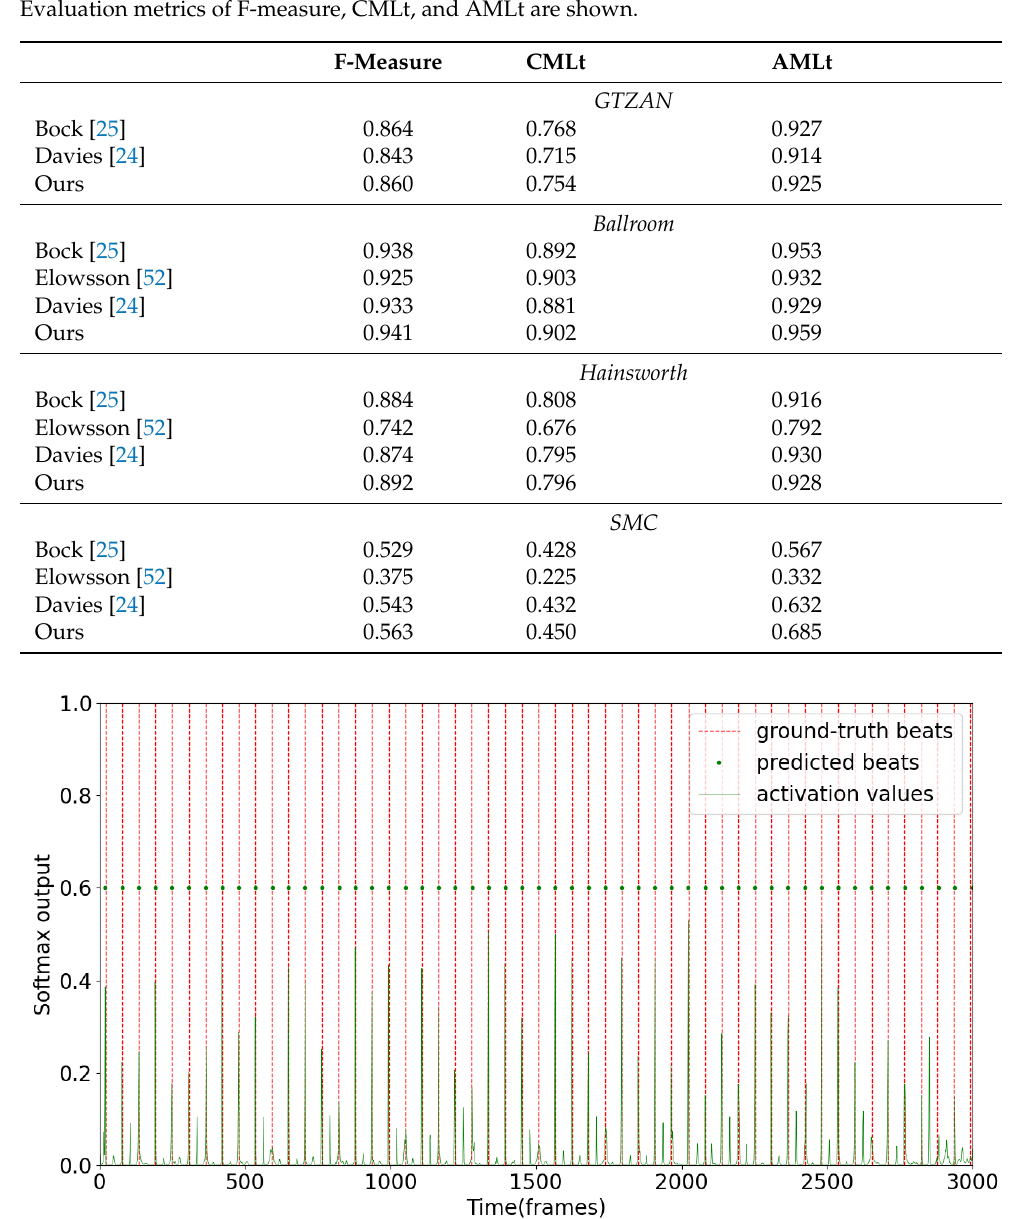
Figure 3. Beat tracking result of our model on a test music